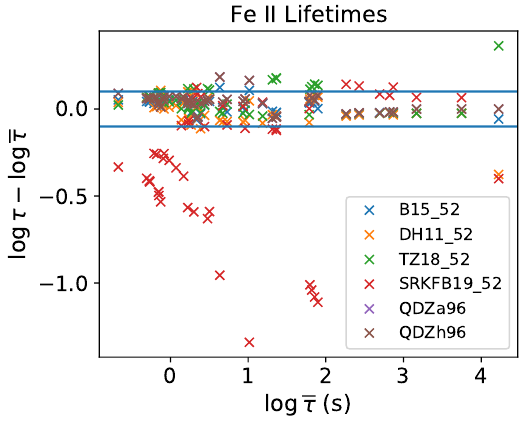
Figure 11. [Fe II ] radiative lifetimes for levels within the 3d 6 4s, 3d 7 , and 3d 5 4s 2 configurations computed from the A -values in the atom datasets B15_52, DH11_52, TZ18_52, SRKFB19_52, QDZa96, and QDZh96. For each level, the lifetime differences for these datasets with respect to the average value are plotted as a function of the average